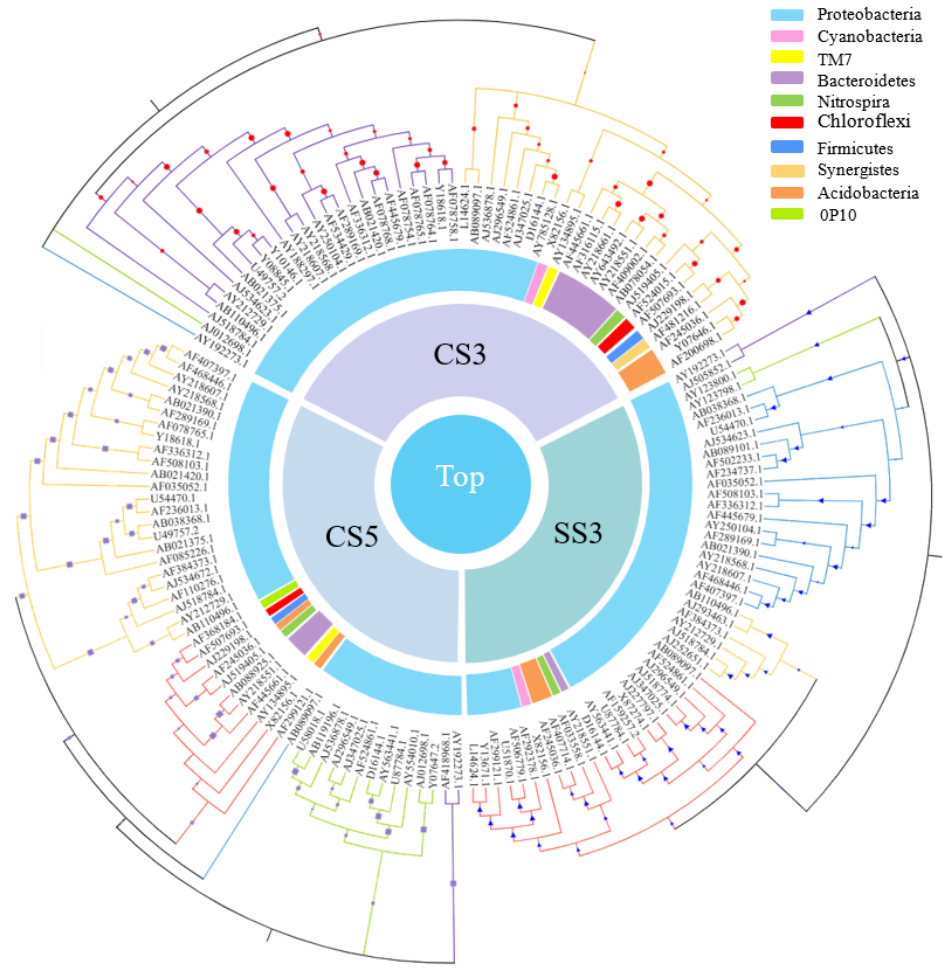
Figure 7. Phylogenetic relationships of the top 50 most abundant genera of the bacterial community for each